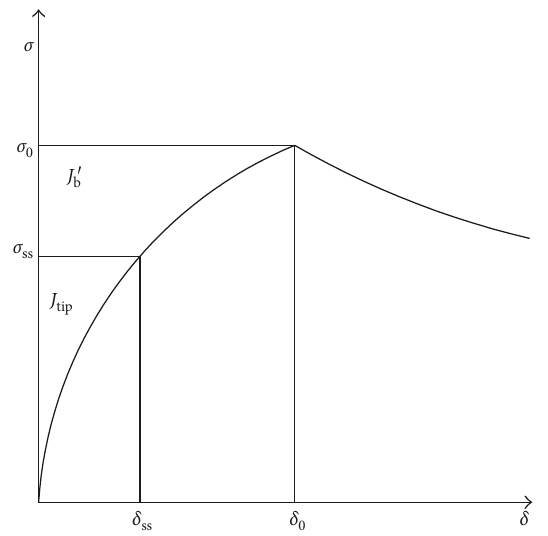
Figure 1: Typical σ